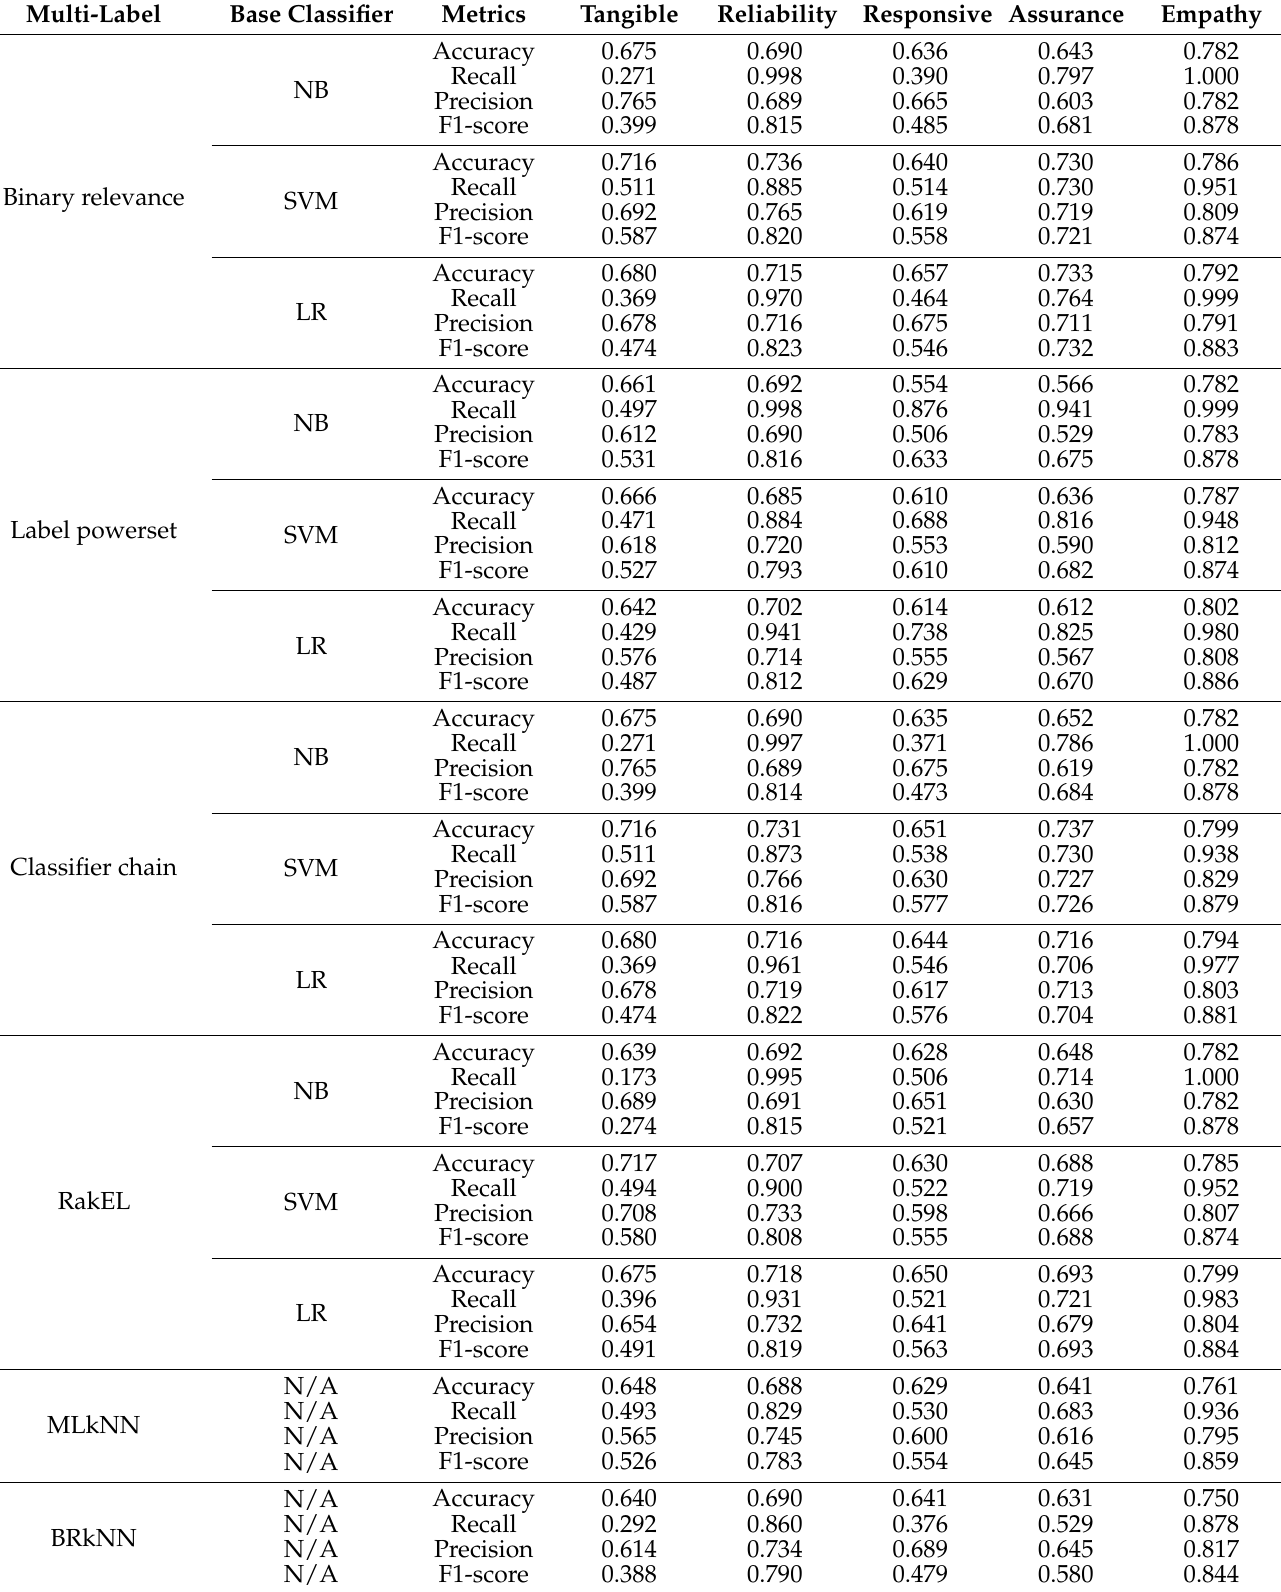
Table 2. Performance metrics for each SERVQUAL dimension of MLQC following 5-fold cross